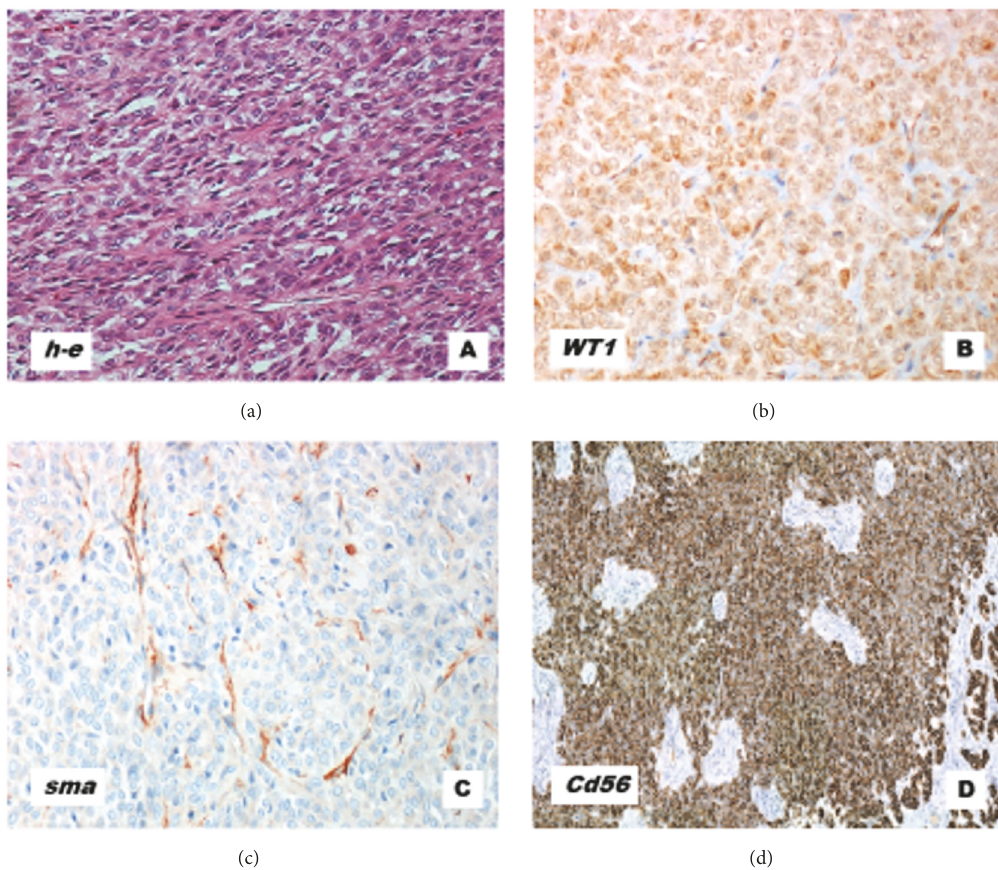
Figure 2: Uterine tumor resembling an ovarian sex cord tumor. (a) Cords, nests, and trabeculae are seen, reminiscent of sex cord cells tumor of the ovary (H-E, 10x). (b) Positive stain for WT1 (10x). (c) Negative stain for smooth muscle actin (SMA, 10x). (d) Positive stain for CD56, a sex cord marker (10x).